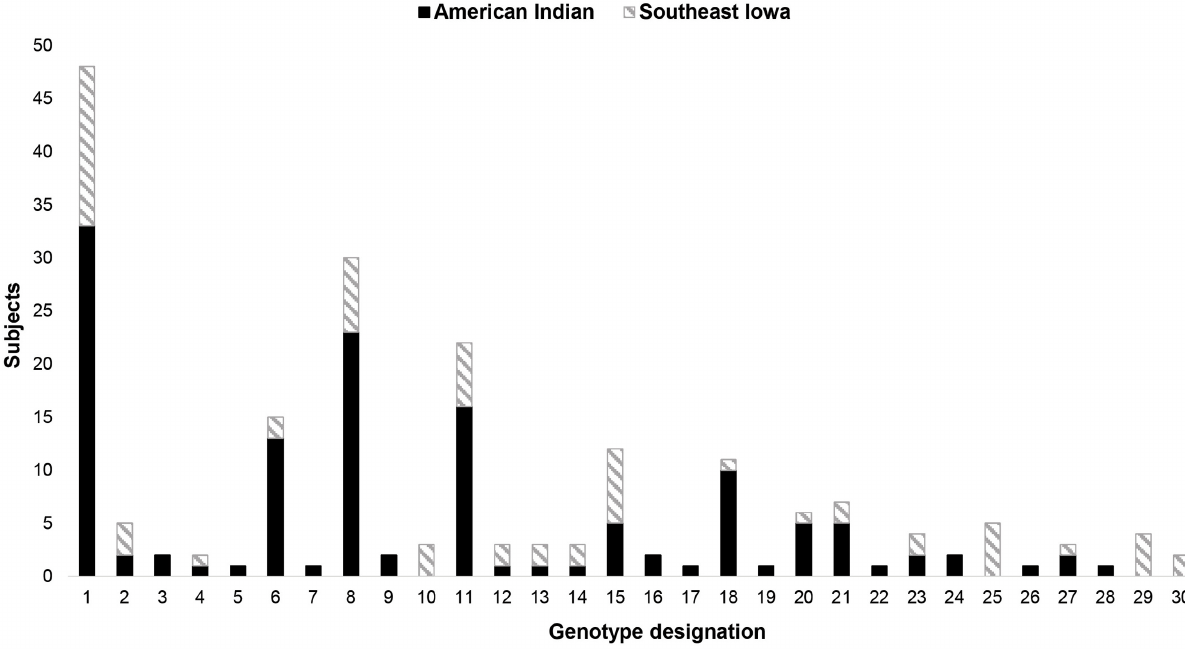
FIGURE 2 | Dendrogam analysis of the S. mutans isolated from both populations. Thirty unique genotypes identified – 15 found in both populations, 11 found only in the AI cohort, and 4 found only in the SEI